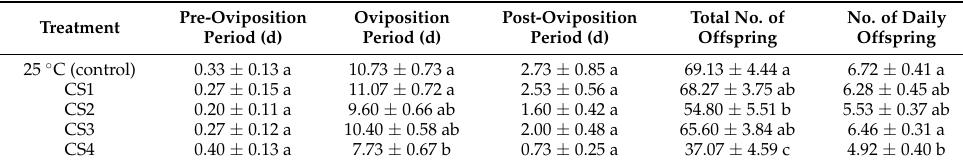
Note: Data are presented as mean ± SE. Different lowercase letters indicate significant differences at the 0.05 level by Tukey’s test. CS1: cold storage 1, late-age pupae stored at 13 ◦ C for 10 d; CS2: cold storage 2, middle-age